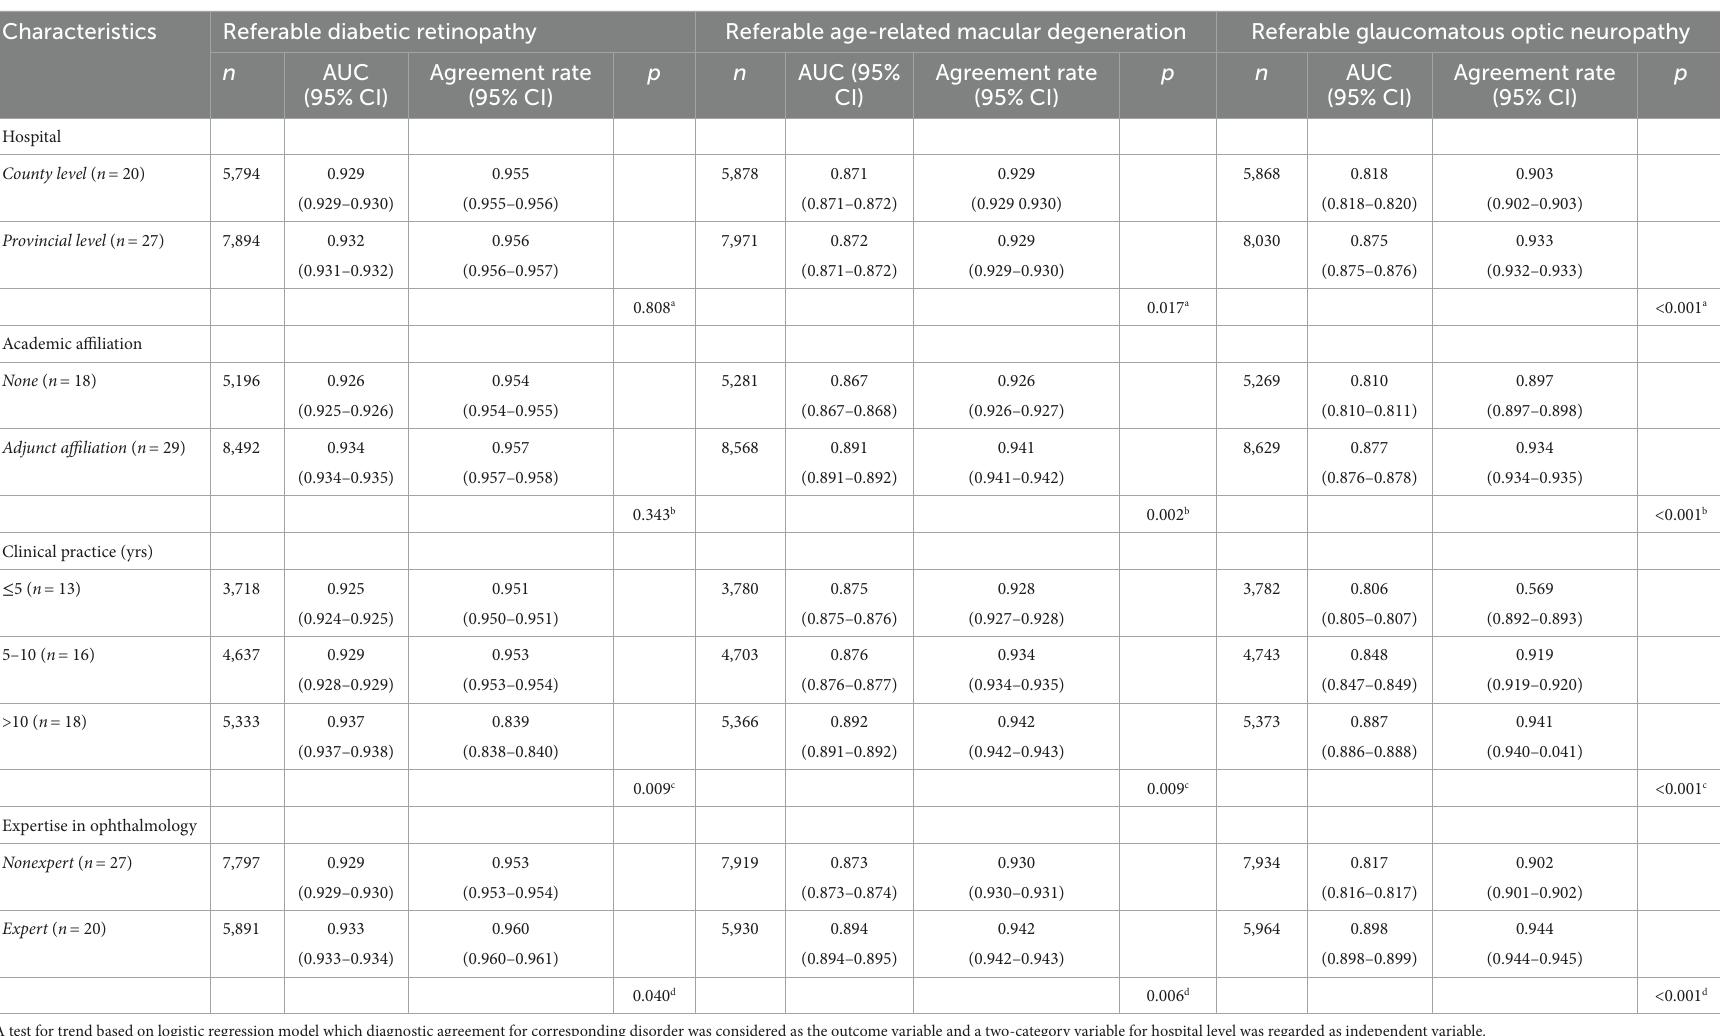
TABLE 4 Ophthalmologist characteristics for image interpretation versus expert consensus reference